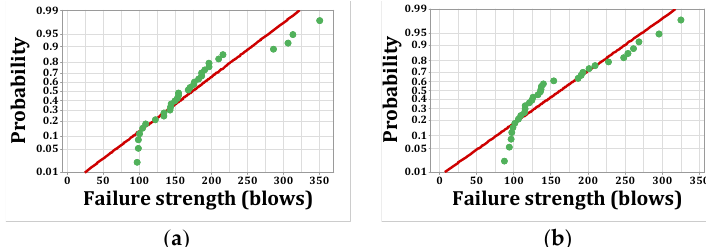
Figure 27. Normal probability plots for failure strength (dry): ( a ) F5, ( b ) F2F3. Figure 20a shows the frequency histogram with the normal plot, and Figure 21a shows the normal probability plot for the failure resistance R. Additionally, the p -value of the K–S test, which is equal to 0.068, is the result of a seldom normal distribution for this mixture. Figures 20b and 22a,b, which are related to mixtures of F2, F5, and F2F3, respec- tively, show a relatively close fit of the normal plot to the histogram. In addition, Figures 21b and 23a,b demonstrate the almost linear pattern of the mixed data. The p -value for mixtures F2, F5, and F2F3 by the K–S test indicates a number greater than 0.15, which confirms the normal distribution of these mixtures. For the F3 mixture, Figures 20c and 21c, plus the p -value (0.087), show that a normal distribution is rare. Reference concrete in a dry environment also rarely shows a normal distribution due to the poor display in Fig- ures 24a and 25a. The p -value for this mixture is equal to 0.075, which confirms its rarely normal distribution. The F2 mixture shows a normal distribution due to the relatively